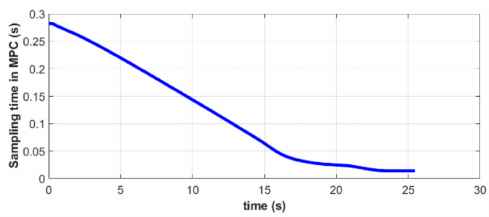
Figure 10. Sampling time of the MPC controller in simulation A.